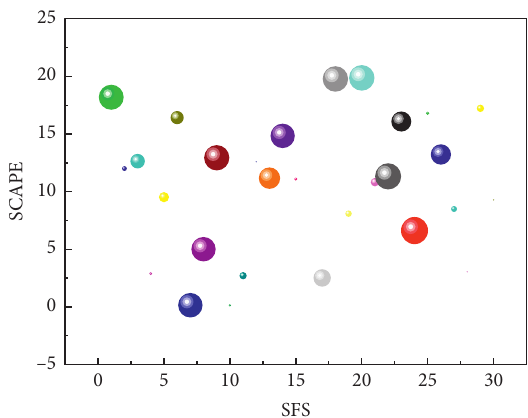
Figure 8: Performance of SFS and SCAPE models at different